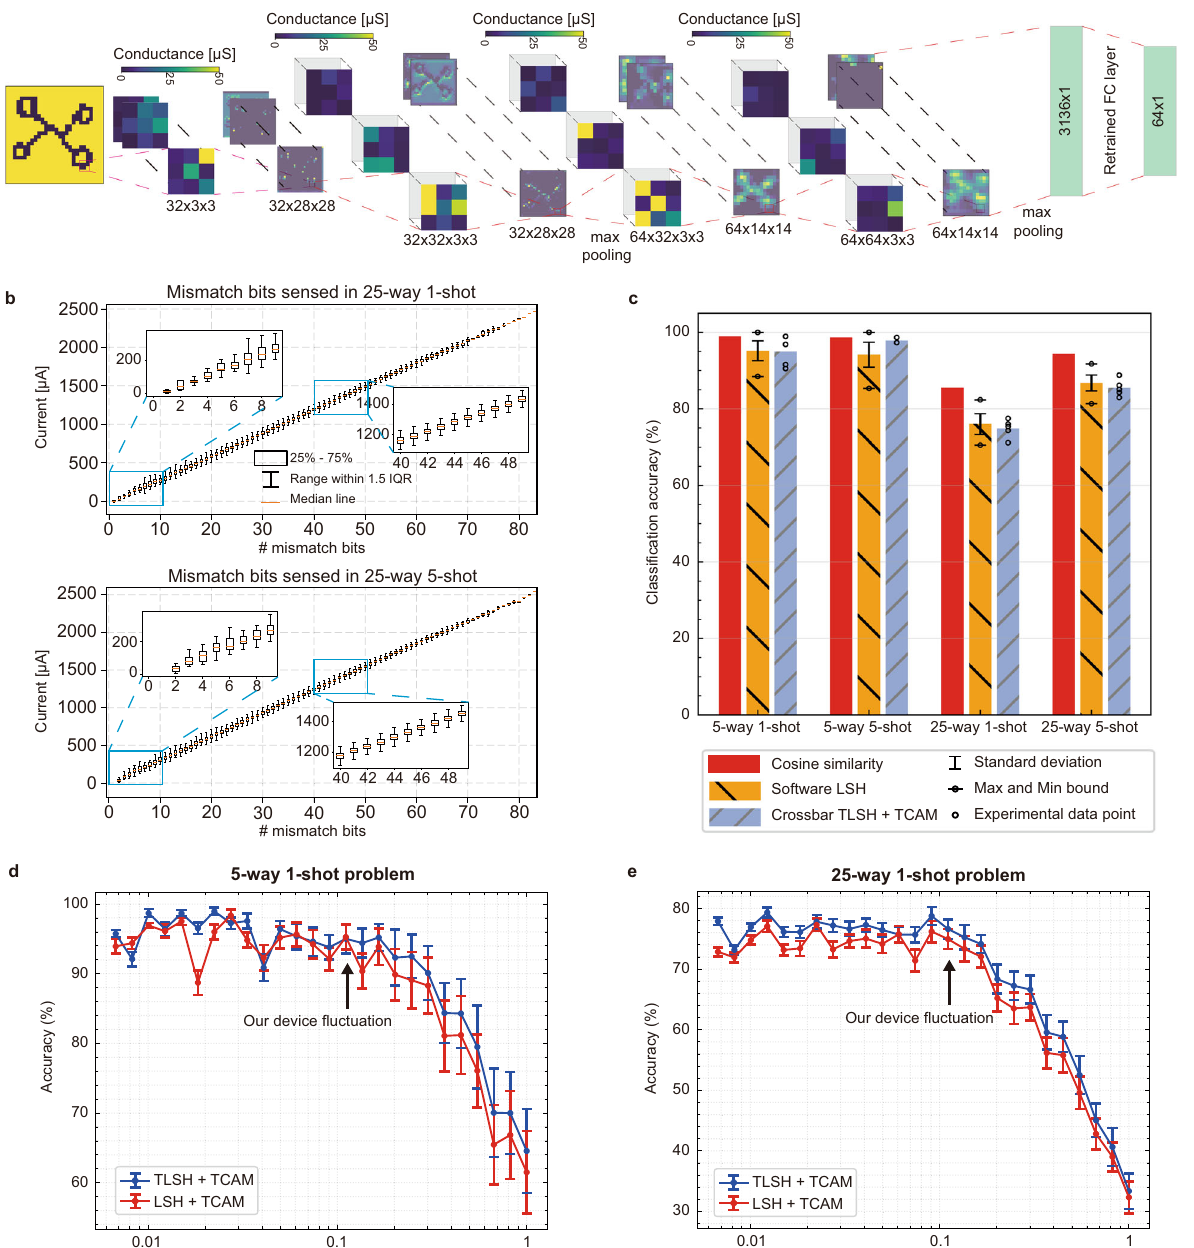
Fig. 4 | Experimental demonstration of few-shot learning with memristive crossbar arrays. a Schematic of CNN structure implemented in the memristor crossbar array. The conductance shows the weight mapping of CNN kernels. The format of dimension representations in the fi gure follows the Output channel (O), Input channel (I), Height (H), and Width (W). The conductance maps representing the whole CNN kernels are shown in Supplementary Fig. 10. b Linear relationship between the sensing current from the crossbar-based TCAM and the number of mismatch bits during the search operations. c Classi fi cation accuracy with cosine